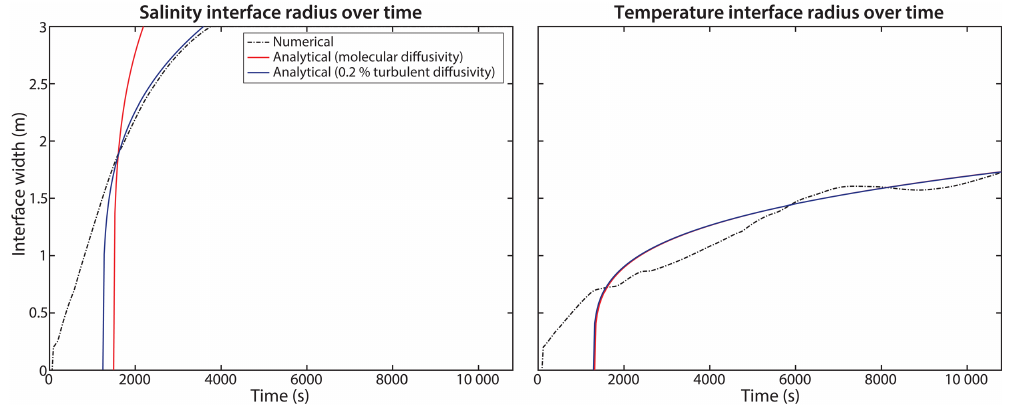
Figure 14. Evolution of the interface between a warm and fresh water body and a bottom cold and saline layer developing form a central inflow (Case 5). After t 1700s, the flow in the numerical results becomes laminar and differences between the temperature and salinity in- = terface growth become visible. Analytical results are plotted for the assumptions of completely molecular diffusion (red) and for diffusivities that are 0.2% influenced by turbulent diffusion (blue).